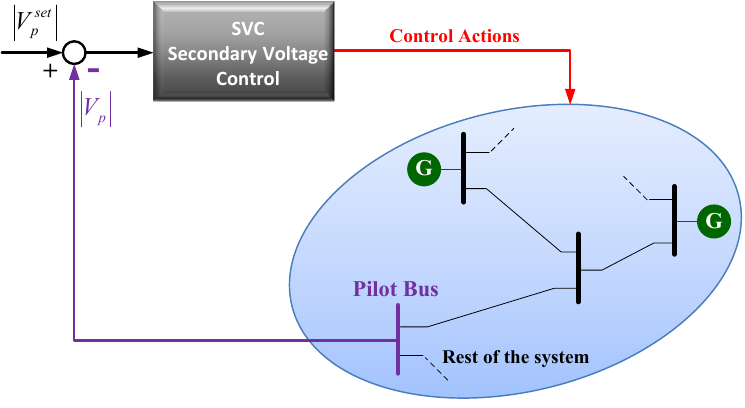
Figure 1. Secondary voltage control (SVC) in a power grid.